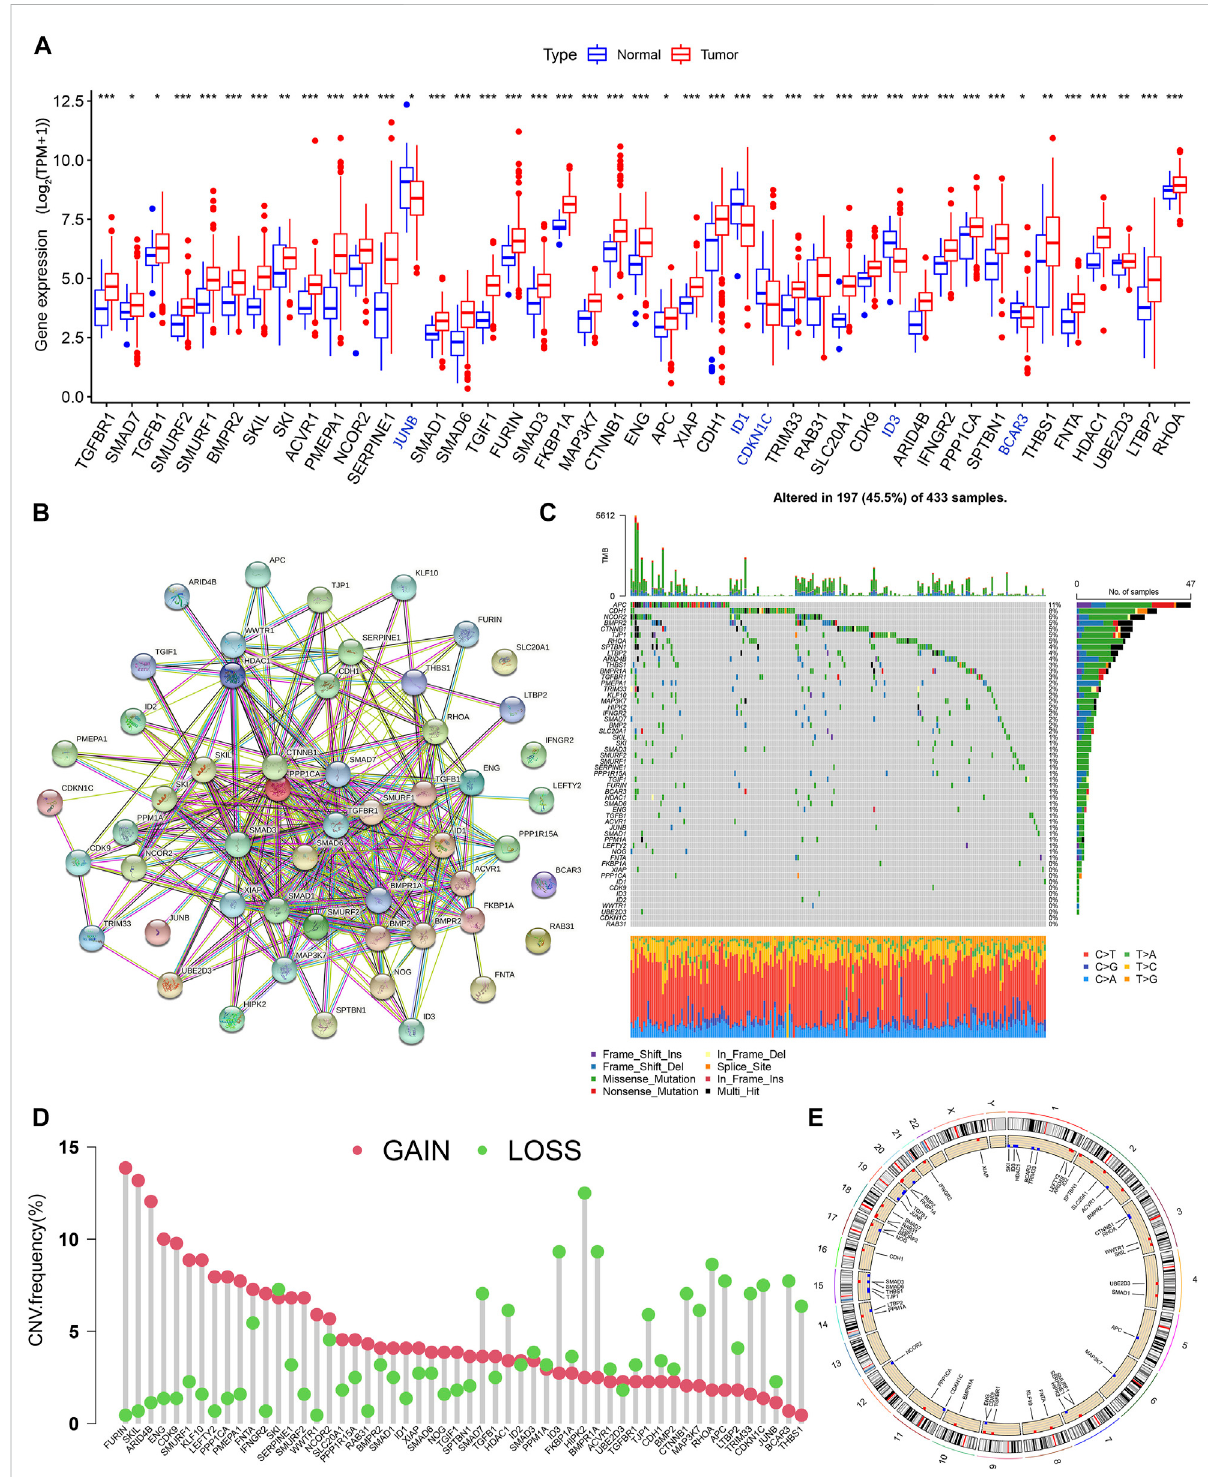
FIGURE 1 Genetic mutational characteristics of TSRGs in gastric cancer, (A) Differential expression analysis of TSRGs in gastric cancer and normal tissues. (B) Protein-protein interaction network analysis of TSRGs in the STRING database. (C) Mutation frequency analysis of TSRGs in gastric cancer. (D) Frequencies of CNV gain, loss, and non-CNV among TSRGs. (E) Locations of CNV alterations in TSRGs on chromosomes. TSRGs, TGF- β signaling related genes; CNV, copy number variant; *p < 0.05; **p < 0.01; ***p <